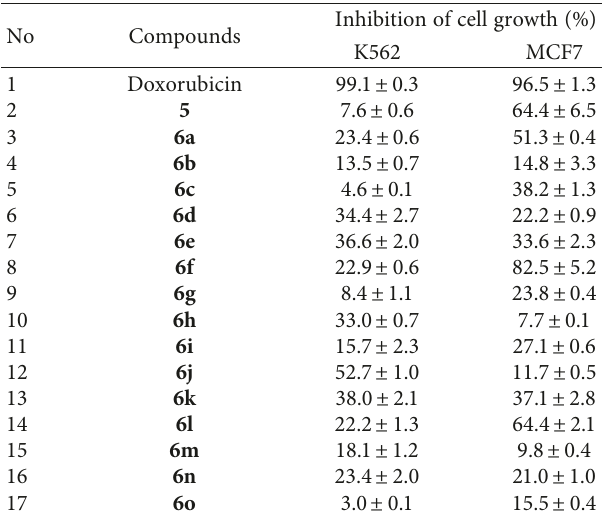
Table 1: The selective cytotoxicity of compounds 5 and 6a–o against K562 and MCF7 cell lines